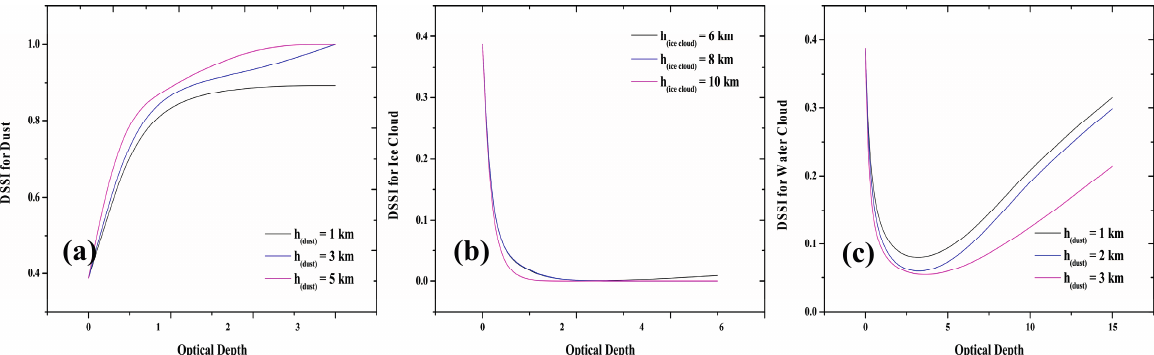
Figure 6. The effect of layer height—h on DSSI under the conditions of ( a ) dust ( b ) ice cloud ( c ) water cloud.